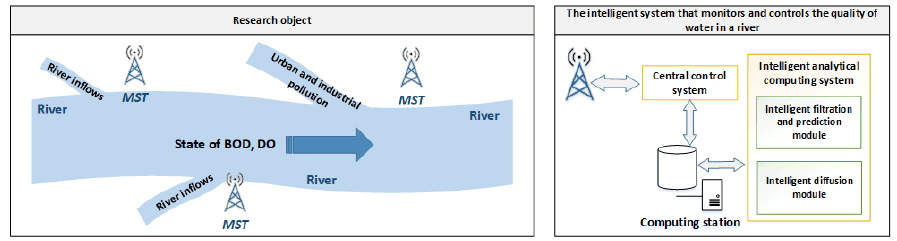
Figure 1. Intelligent river water quality control and monitoring